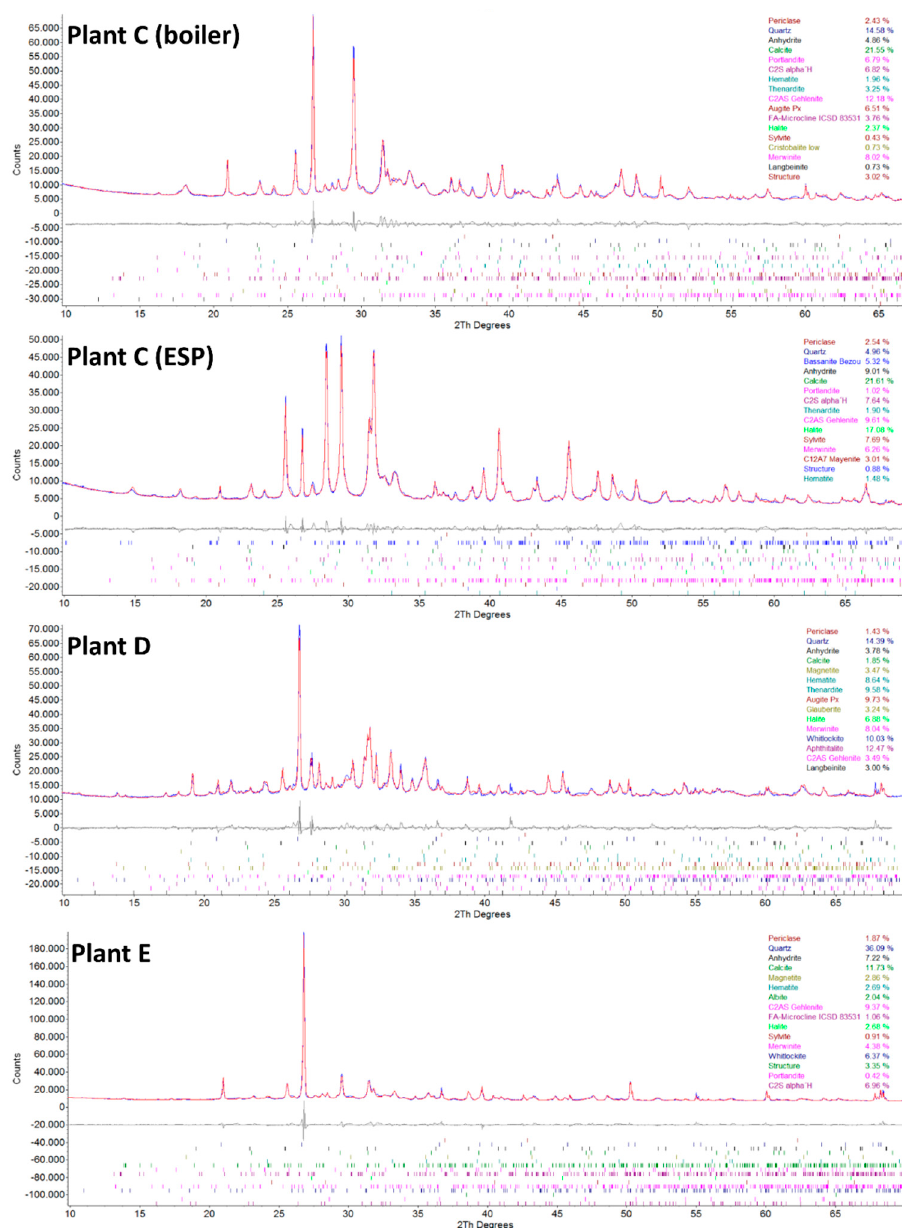
Figure 6. Powder XRD graphs showing the results of the Rietveld refinements (blue = measured di ff ractogram, red = calculated di ff ractogram, and gray = di ff erence plot) of plant A (fly ash sample A), plant B (fly ash sample B), plant C (boiler) (fly ash sample C-boiler), plant C (ESP) (fly ash sample C-filter), plant D (fly ash sample D), and plant E (fly ash sample E). The calculated phase percentage